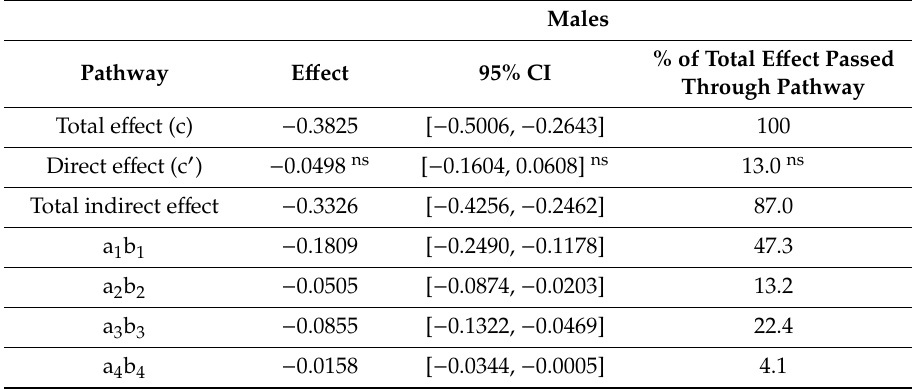
Table A3. Direct and indirect e ff ects for mediating pathways for males of the relationship between stress in 2012 and work ability in 2017 in a parallel design ( n = 575).